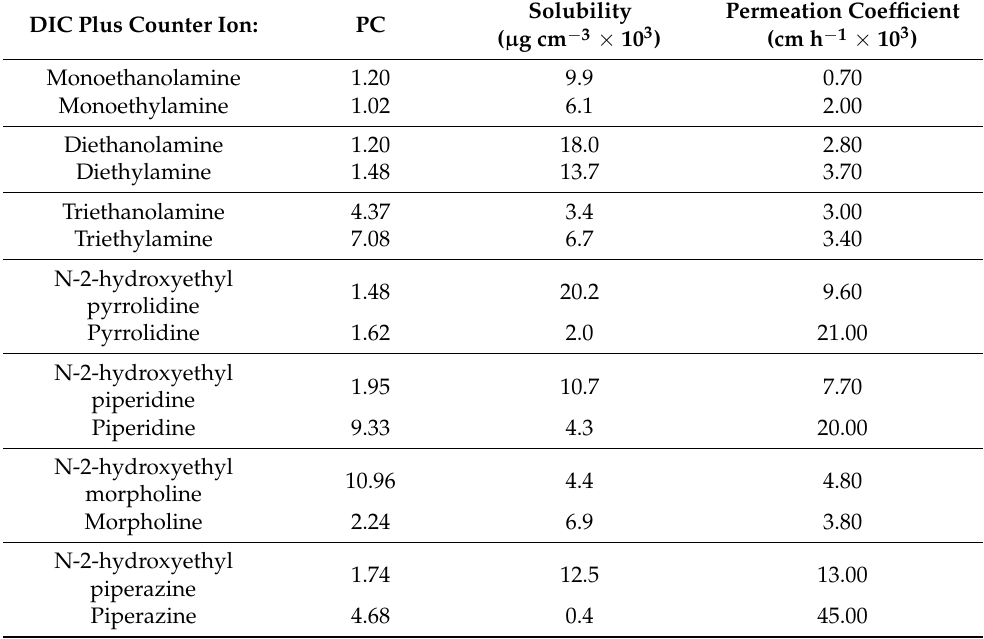
Table 5. Permeation parameters of DIC salts. According to the authors, saturated solutions were applied in permeation studies (for solubility and partition experiments, n = 3; for permeation experiments used to calculate permeation coefficient n ≥ 5; values represent the mean) Adapted from [32], MDPI,